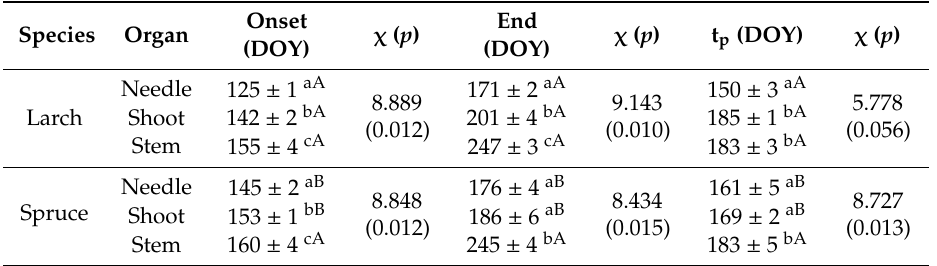
Table 2. Comparison of dates (onset, end, and maximum growth rate) among three organs in larch and spruce (mean ± standard deviations).